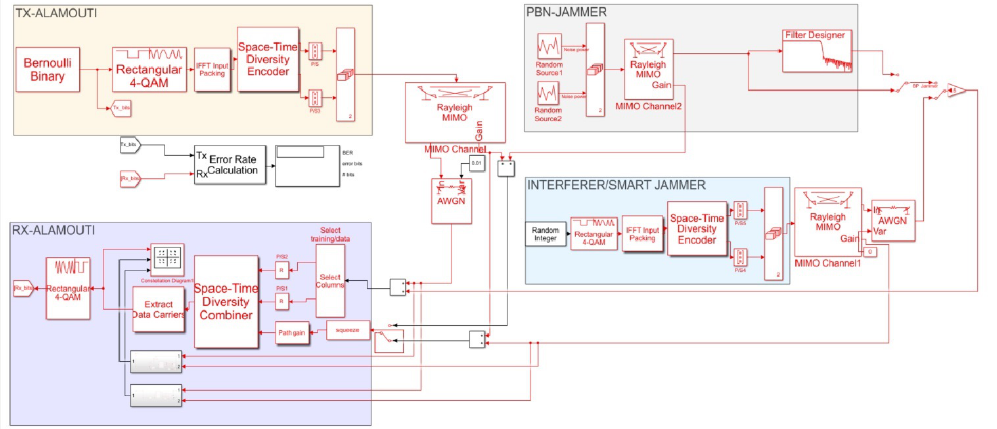
Figure 5. Simulation block diagram using the Simulink